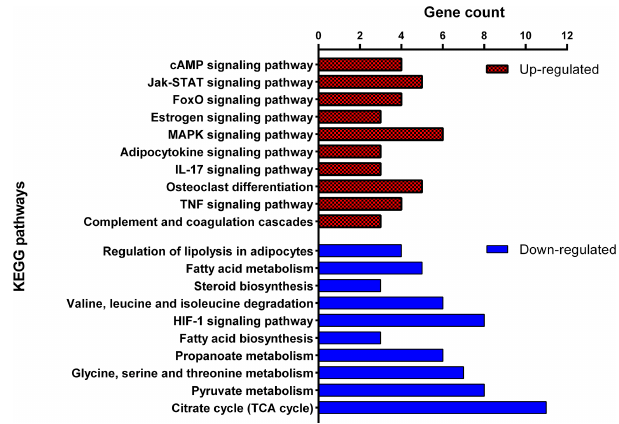
Figure 5. Top 10 significant Kyoto Encyclopedia of Genes and Genomes (KEGG) pathways enriched by up-regulated (red) and down-regulated (blue) differentially expressed genes of adipose tissue of Zel (thin-tailed) compared to Ghezel (fat-tailed) sheep